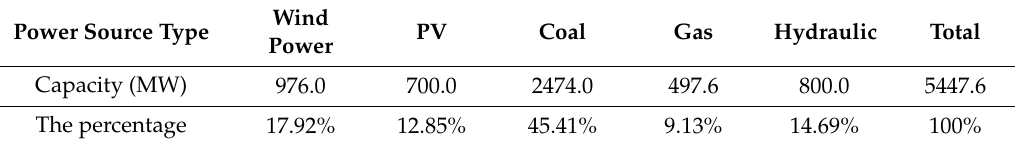
Table 1. Power supply capacity ratio of the power grid.